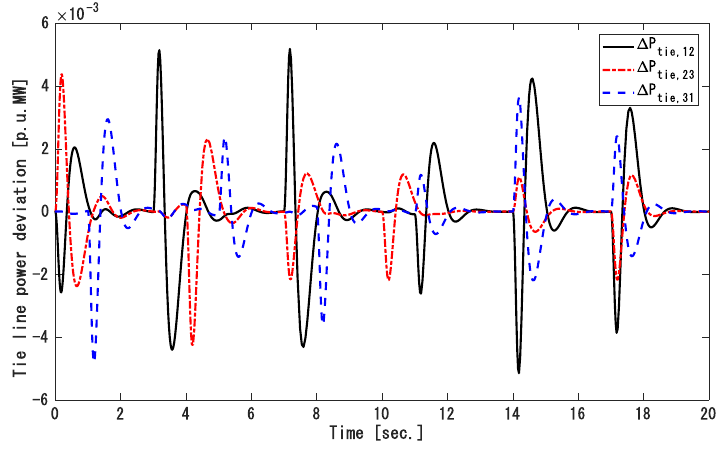
Figure 17. Tie-line variation of 3 areas.